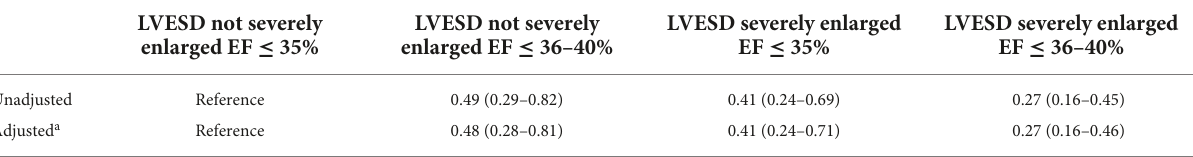
TABLE 1 Odds ratio of EF improvement according to LVESD and EF at baseline.